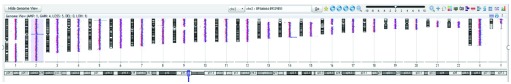
Array-based comparative genomic hybridization chromosomal ideogram and clustering of breakpoints.